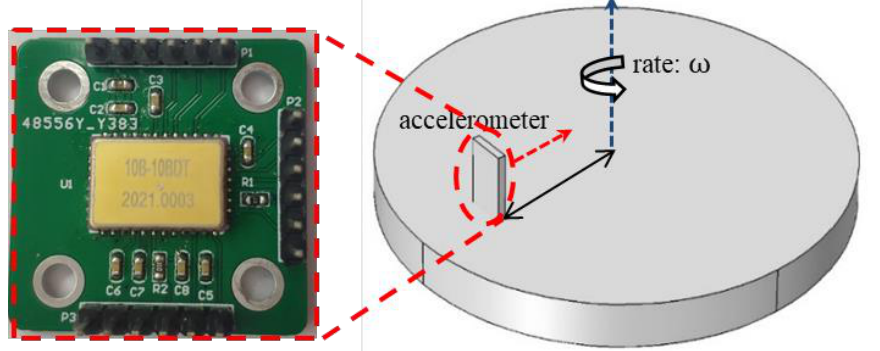
Figure 8. The sensitivity test by the rotating platform.